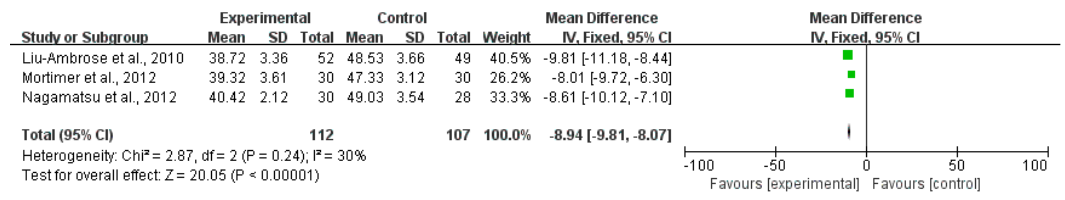
Figure 7. Forest plots of WCST scale outcomes in overall analysis [11,13].